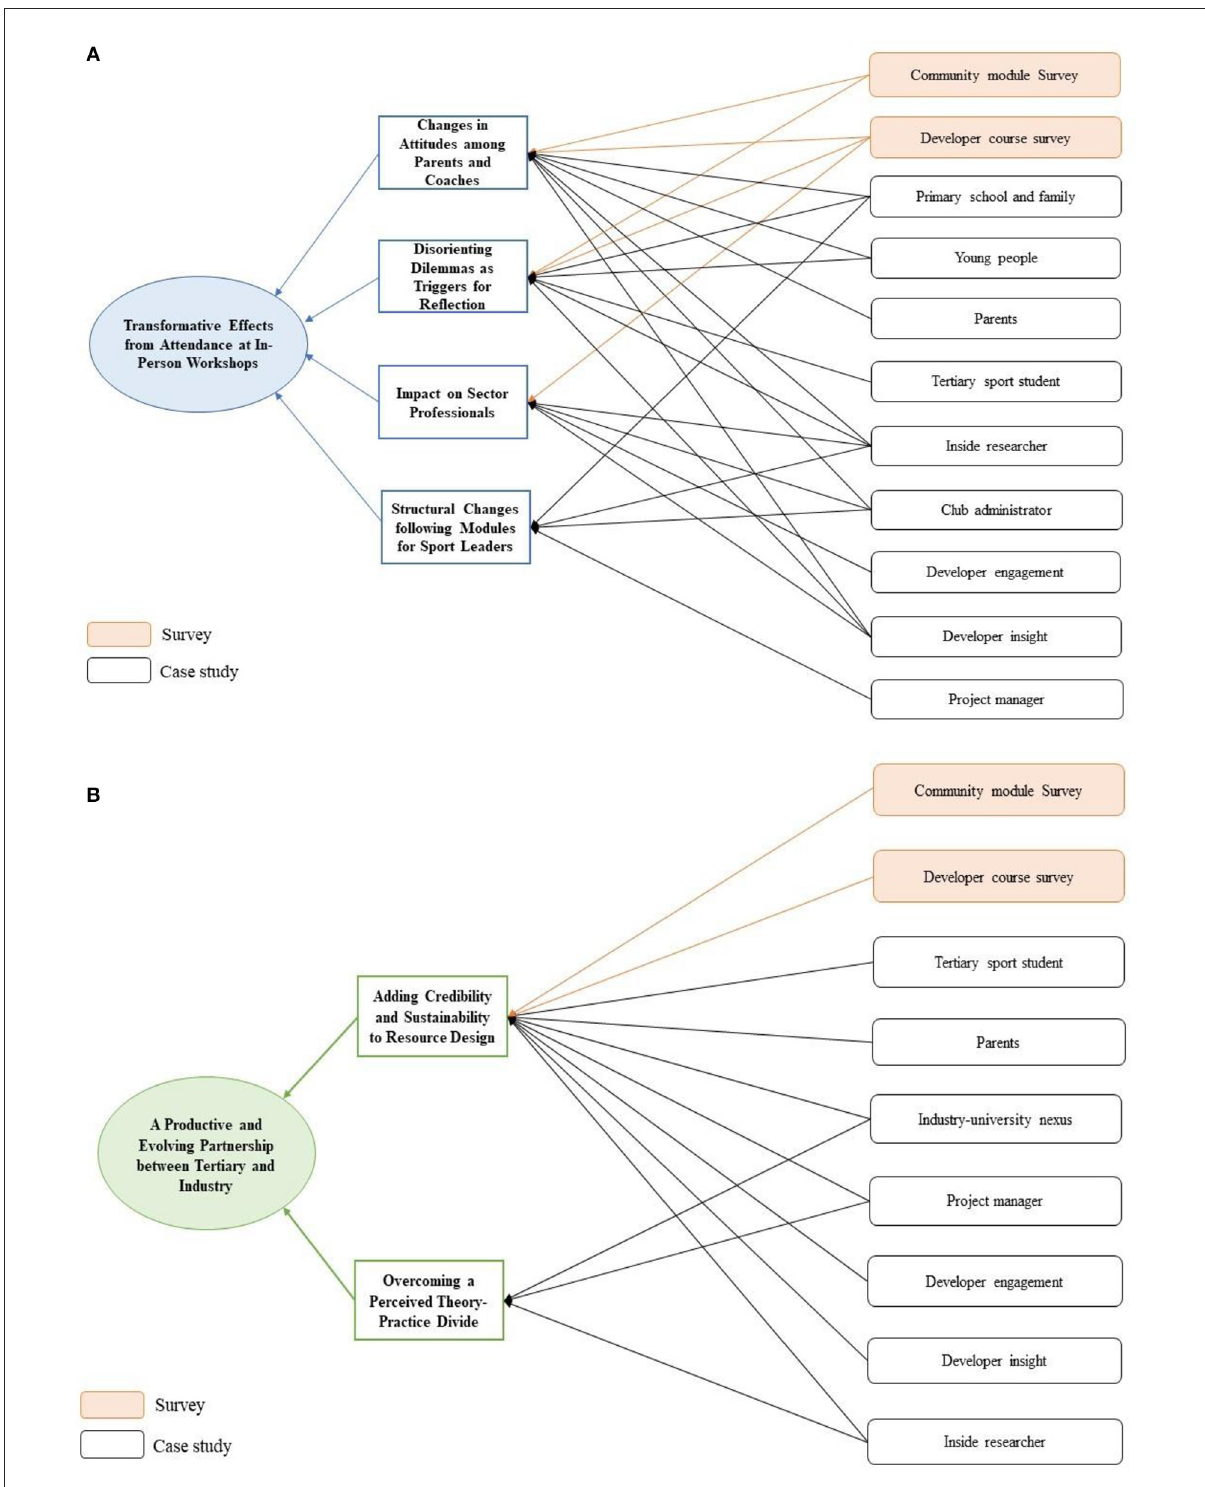
FIGURE6 (A) Transformative effects. (B) A productive and evolving